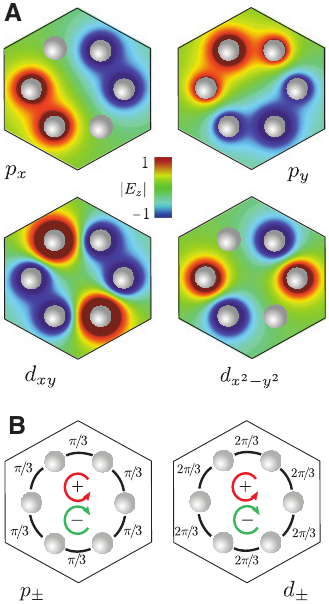
Figure 4: The eigenstates and pseudo-spin states of a single unit cell. (A) The electric fields E of the p - and d -like eigenstates of an z individual unit cell. (B) Pseudo-spin states p and d as linear ± ± combinations of the p - and d -like eigenstates. The phase difference between adjacent dipole moments is shown.